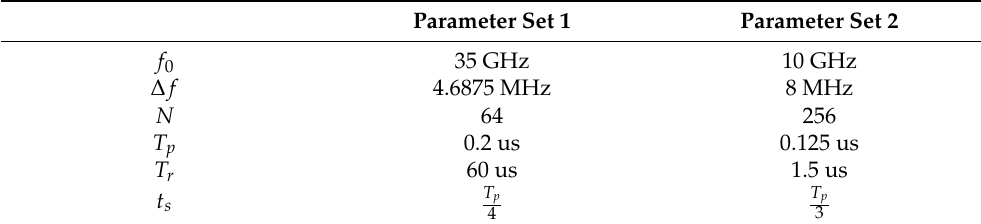
Table 1. The parameter sets of DSF waveforms.